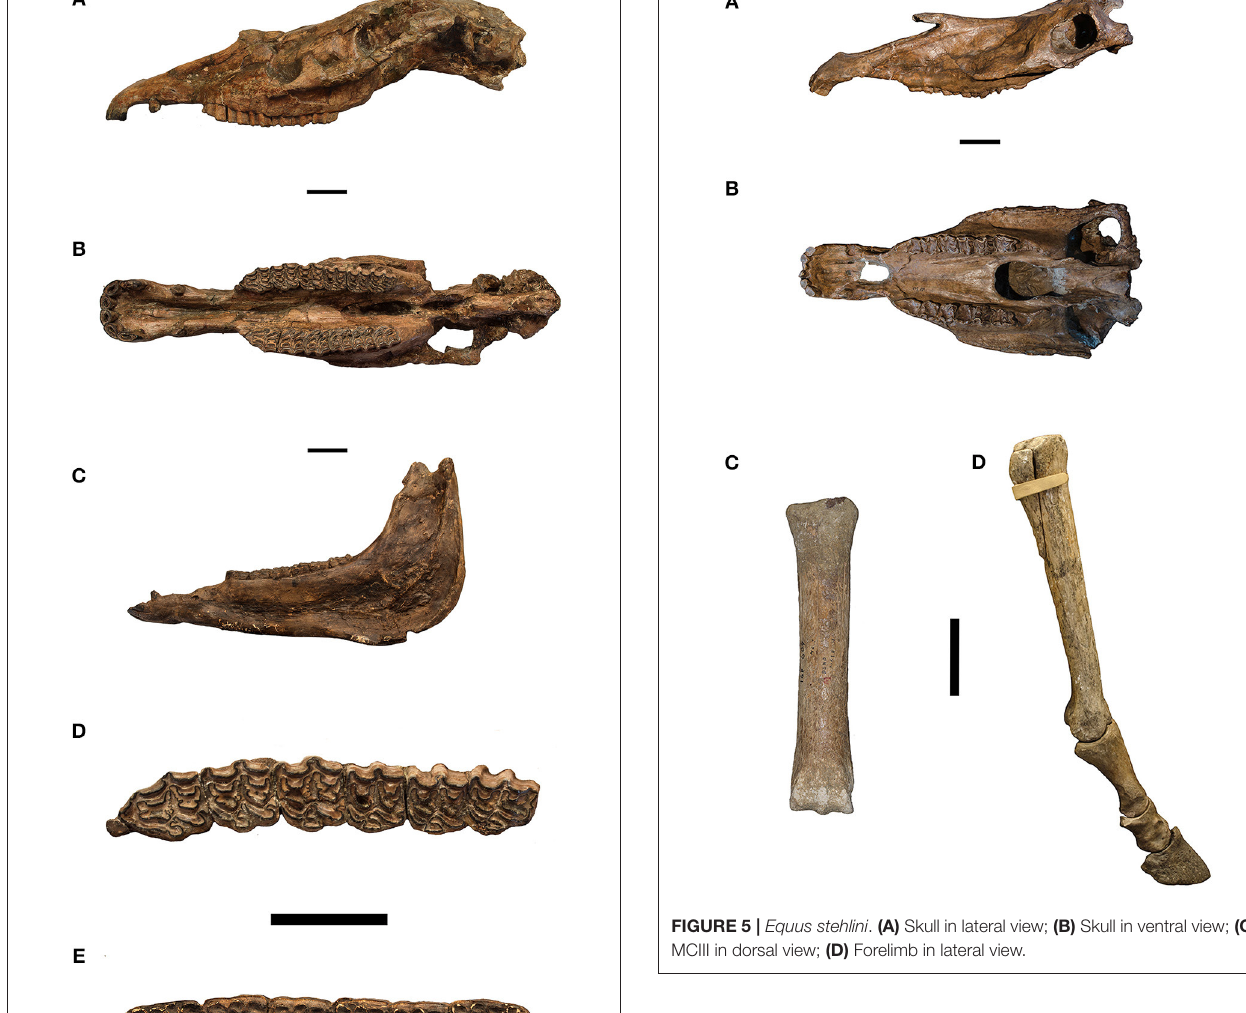
(De Giuli and Masini, 1986). The presence of Equus stehlini